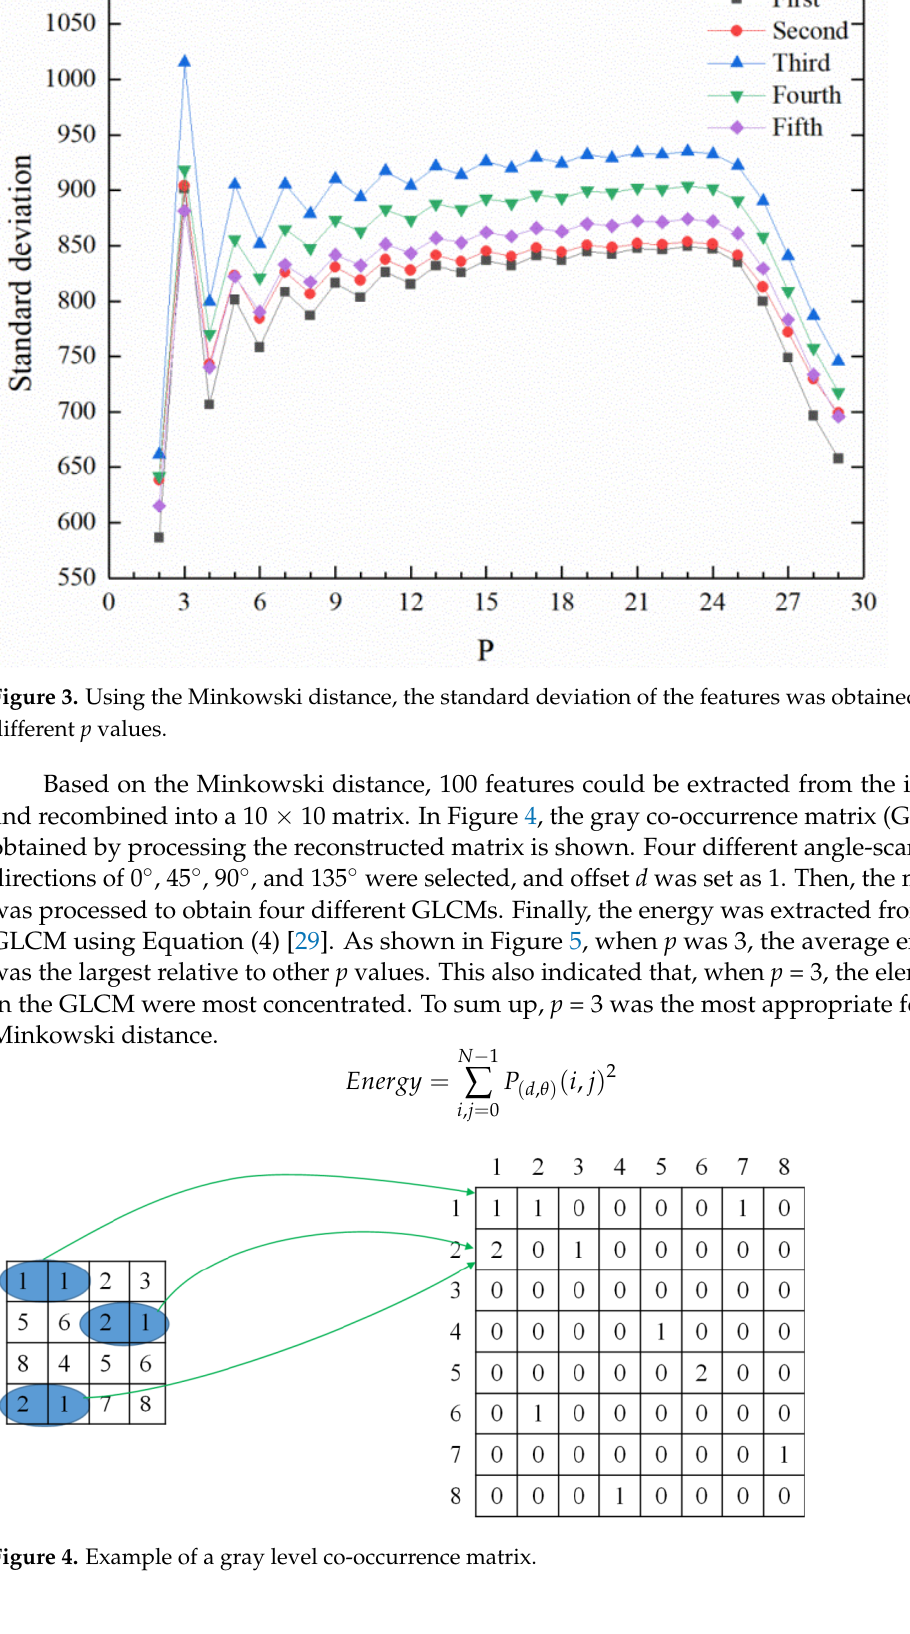
Figure 4. Example of a gray level co-occurrence matrix.